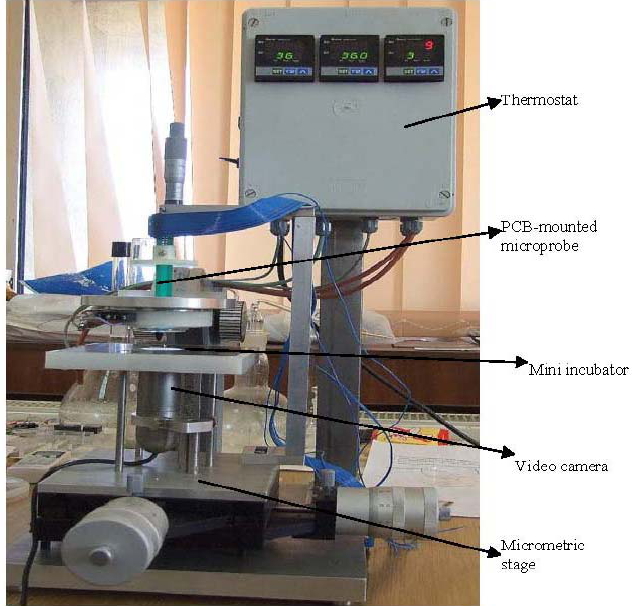
Figure 7. Integrated platform for electrical and optical monitoring of cell cultures.